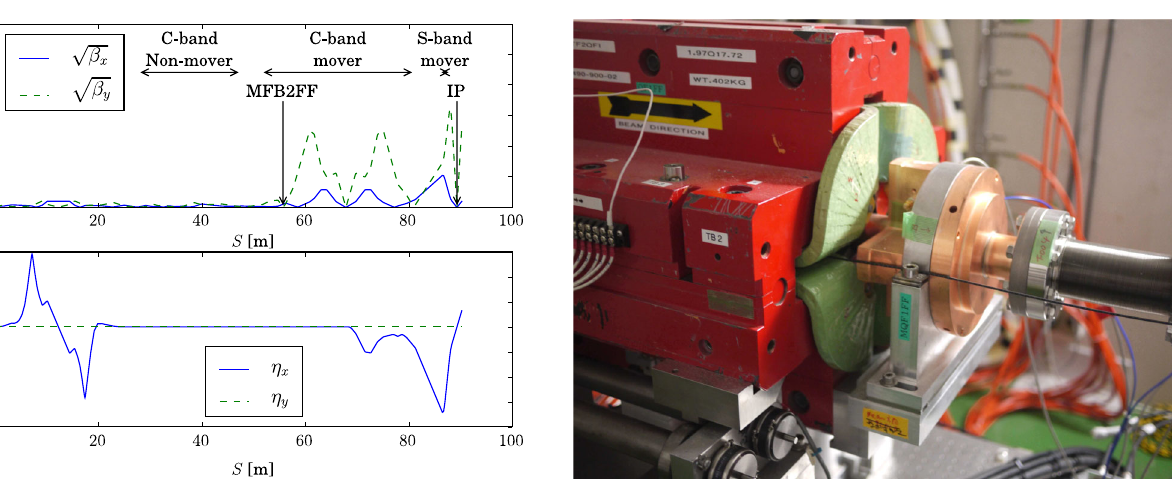
FIG. 4. S -band cavity BPM and associated quadrupole magnet (QF1FF).FIG. 2. ATF2 beta (cid:5) and dispersion (cid:6) as a function of